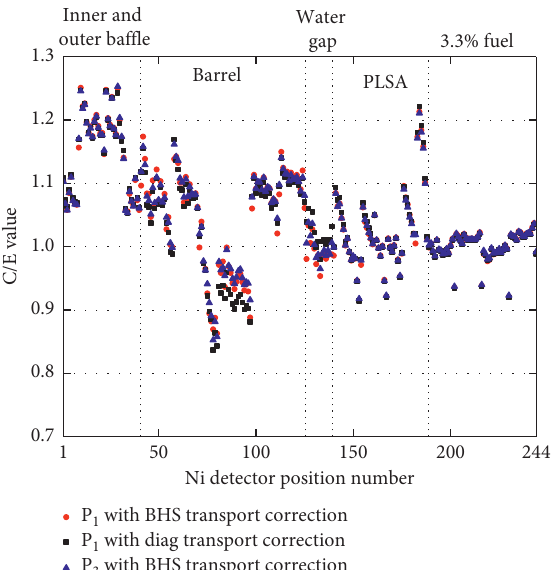
Figure 23: Comparison of P 1 transport correction with P 3 results of the